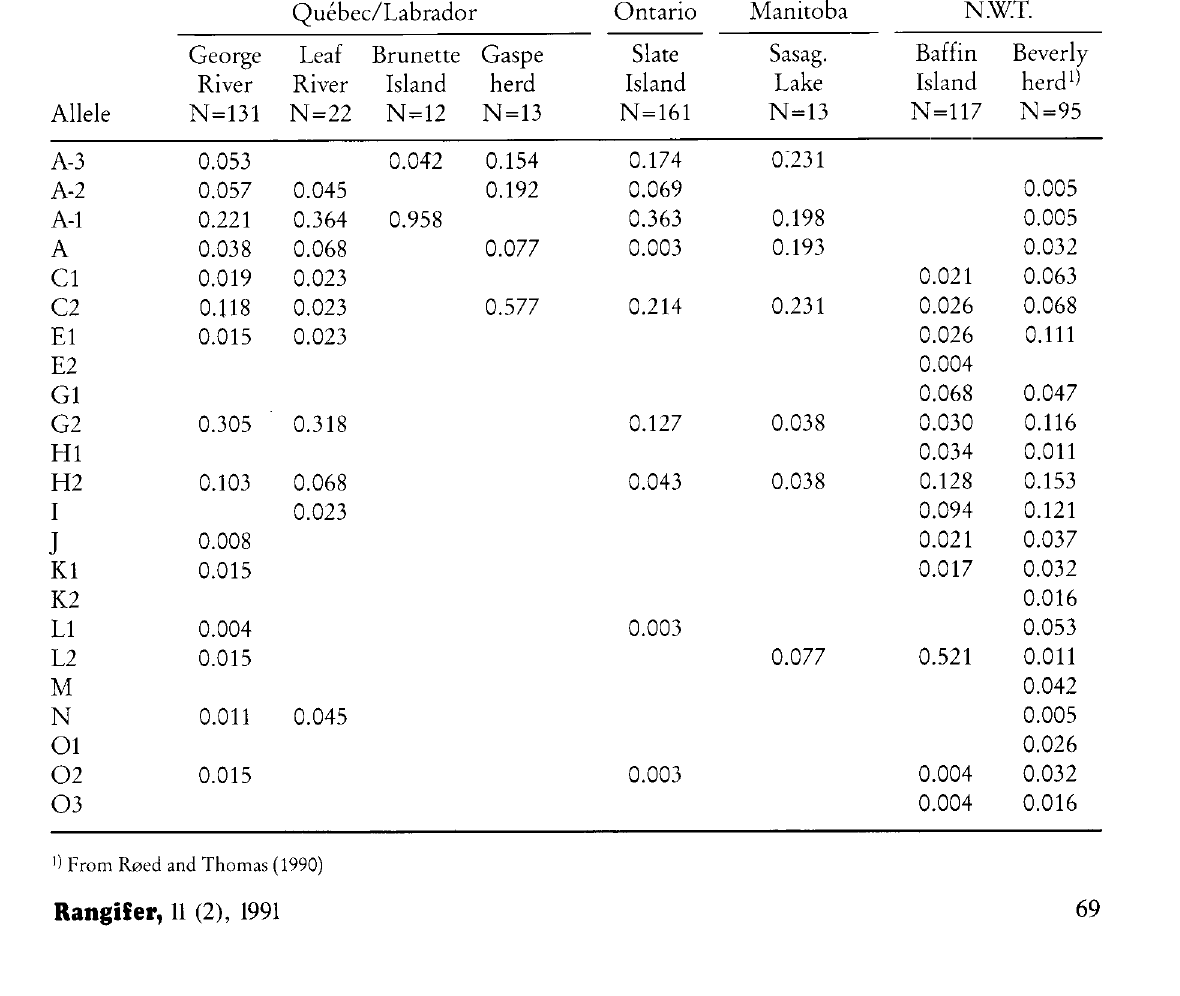
Table 1. Transferrin allele frequencies of caribou indifferent regions of Canada. N=number of individuals